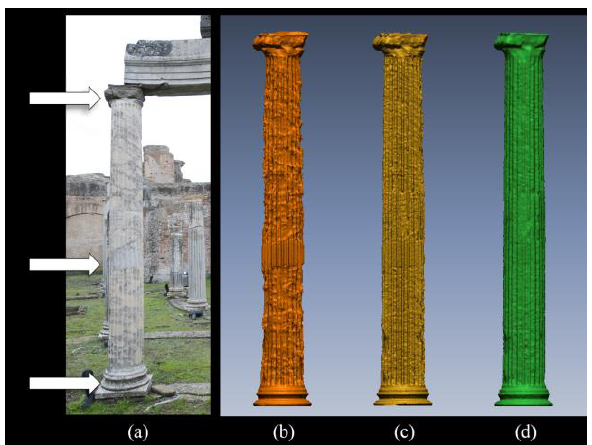
Figure 6. Test phase on marble elements. The restored segment in concrete present an homogeneous result.